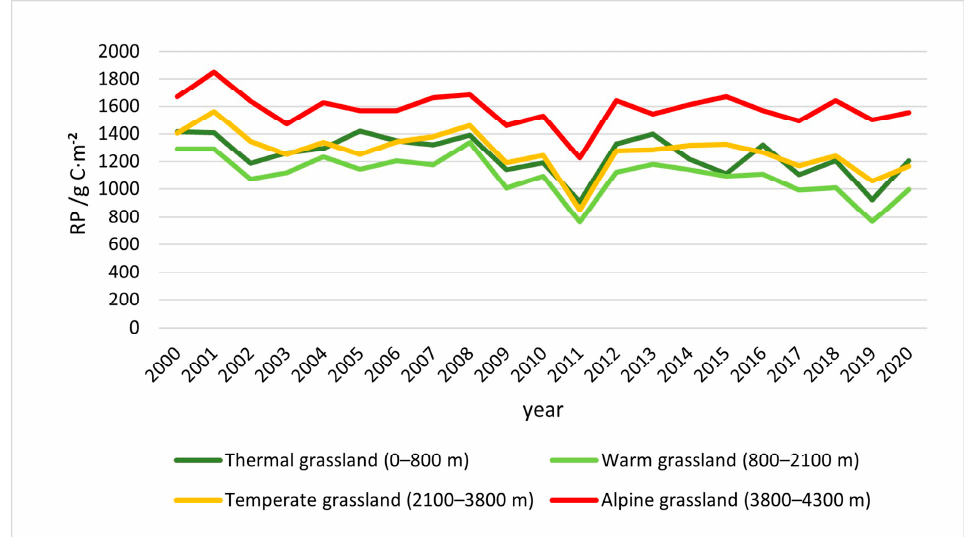
Figure 8. Interannual RP trends of the four typical grassland types.